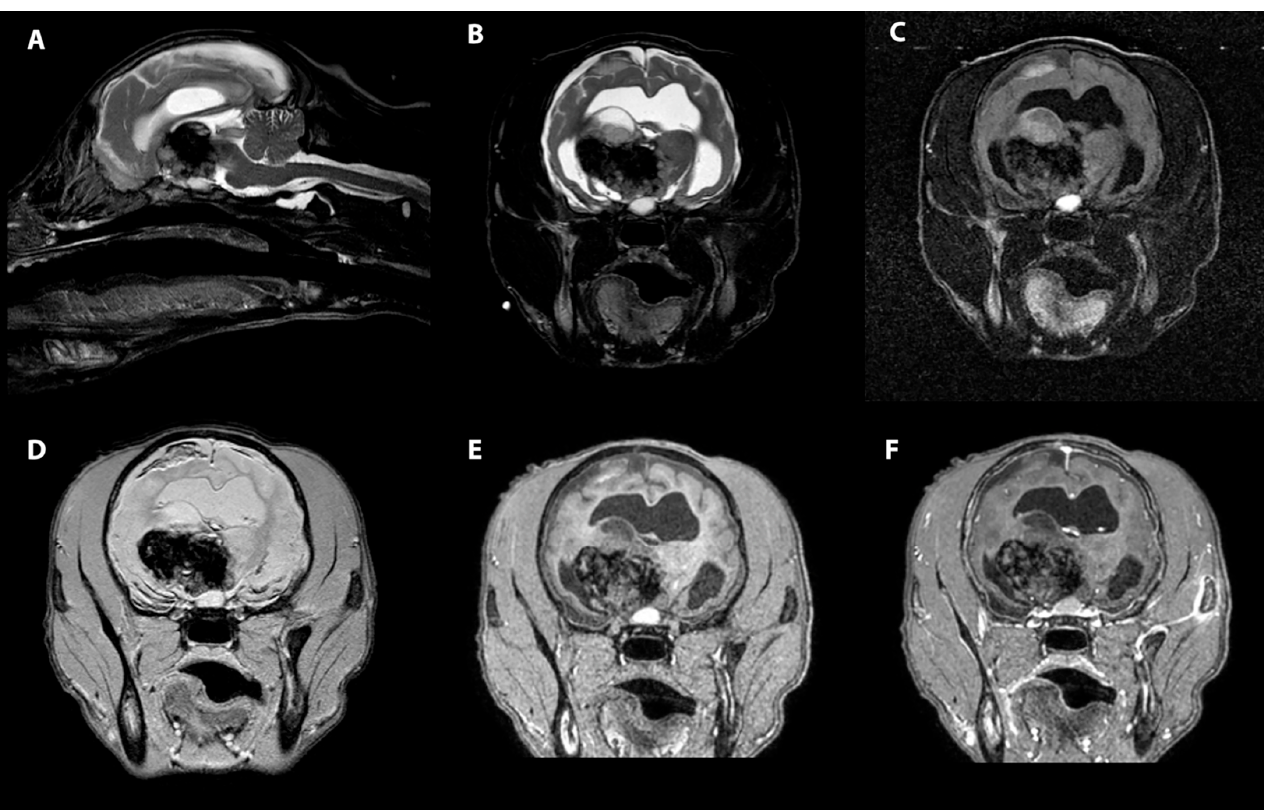
Figure 1. MRI images of the heterogenous intra-axial mass centered in the right thalamus in sagittal T2W ( A ), transverse T2W ( B ), transverse T2-FLAIR ( C ), transverse T2* ( D ), transverse T1W pre contrast ( E ) and transverse T1W post contrast images ( F ). The T1 and T2 hypointensity of the pituitary gland can be seen as well.